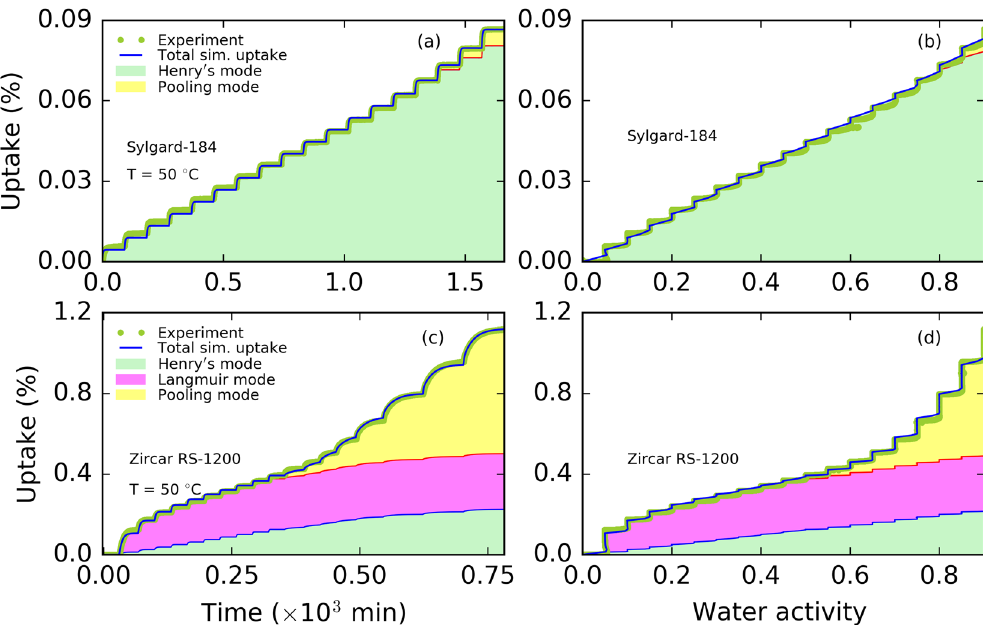
Figure 5. Experimental and simulated mass uptake and individual contributions from triple-mode sorption at 50 °C. Panel a: mass uptake (in %) vs time (in mins × 10 3 ) by Sylgard-184, panel b: mass uptake (in %) vs water activity by Sylgard-184, panel c: mass uptake (in %) vs time (in mins) by Zircar RS-1200, and panel d: mass uptake (in %) vs water activity by Zircar RS-1200. Yellow-green symbols represent the experimental data points, blue lines represent the total simulated uptake from triple-mode sorption. Henry’s absorption mode, Langmuir adsorption mode, and pooling sorption mode contributions to the total mass uptake are shown using light green, magenta, and yellow colors, respectively. Sylgard-184 shows almost all uptake due to Henry’s mode of absorption, whereas Zircar RS-1200 shows the contributions from all three